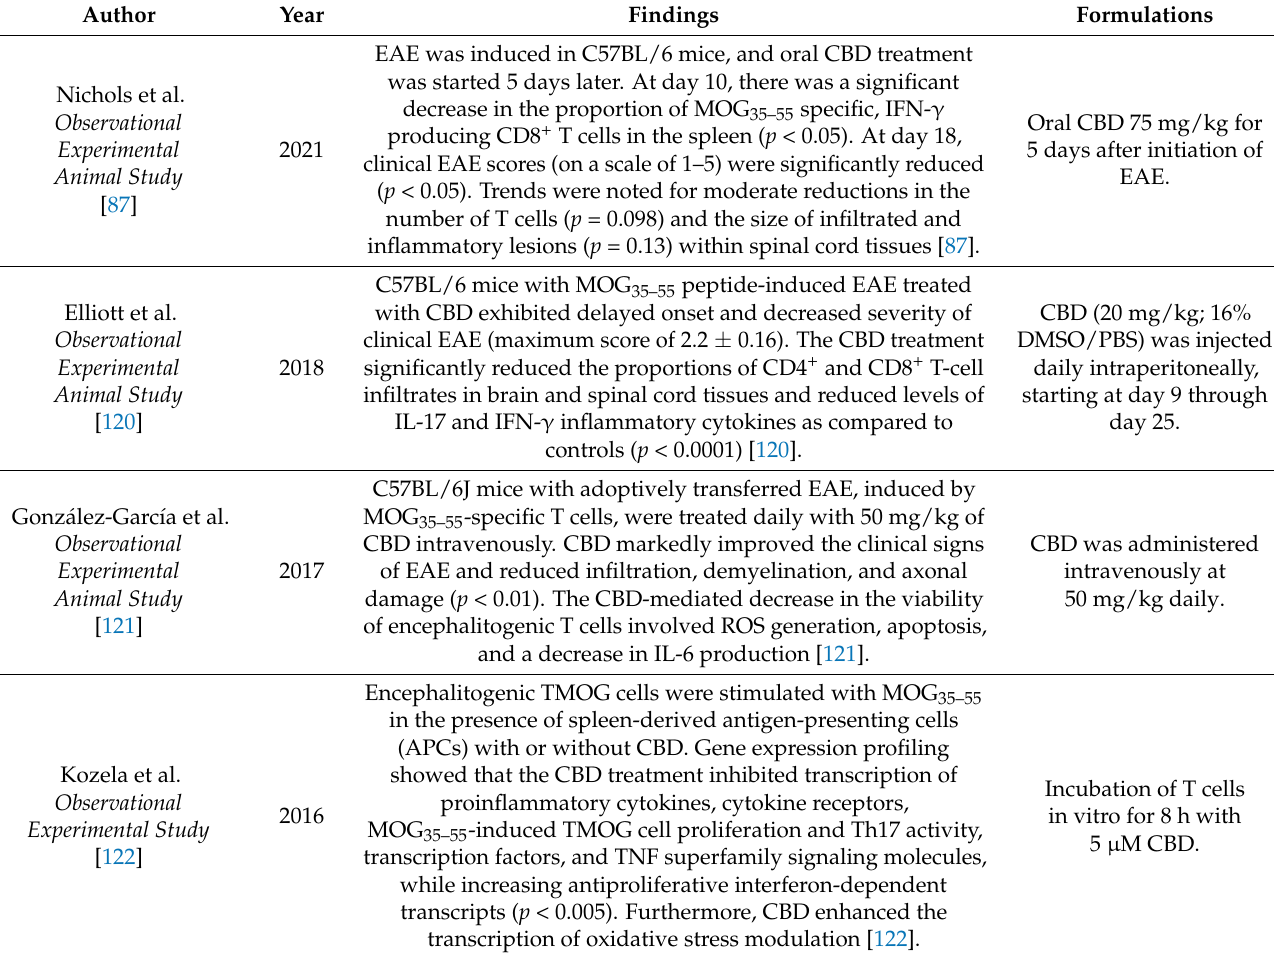
Table 5. Effects of cannabinoids on inflammation and spasticity in EAE animal model of